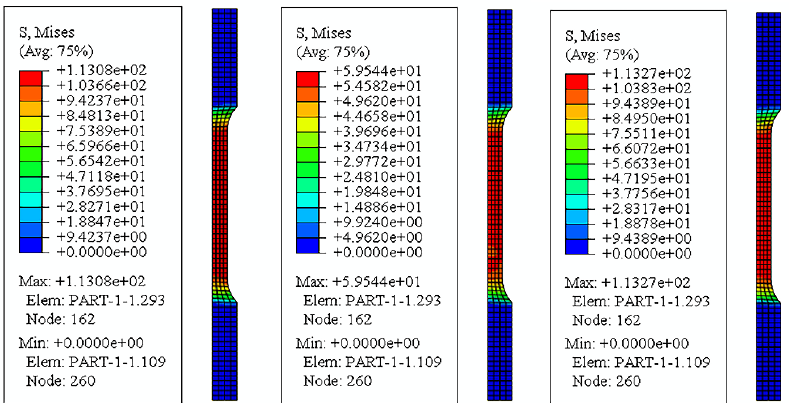
Figure 11. The simulation stress-strain curves under different amplitudes of the ultrasonic frequency 20 kHz: ( a ) Amplitude 4 μ m; ( b ) Amplitude 5.2 μ m; ( c ) Amplitude 6 μ m; and ( d ) Amplitude 7.3 μ m.